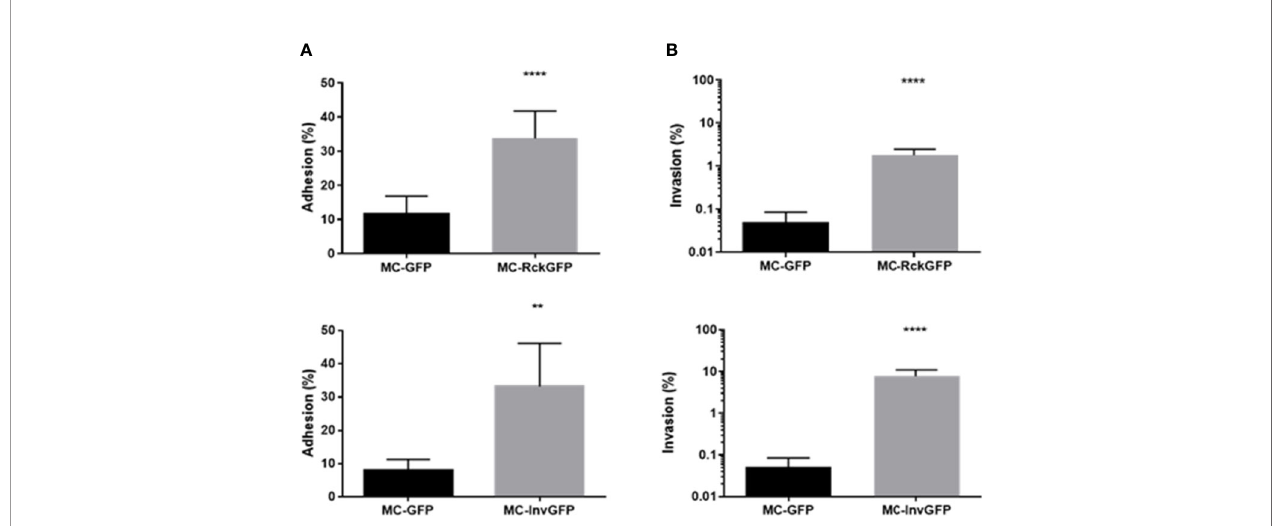
FIGURE 1 | S. Typhimurium Rck and Y. enterocolitica Invasin are able to induce both adhesion and invasion in intestinal epithelial cells. HCT116 cells were infected with MC-GFP, MC-RckGFP or MC-InvGFP strain for 1 h at 37°C (MOI 10:1). The percentage of total cell-associated (A) and intracellular (B) bacteria were calculated as the ratio of CFU of cell lysates and inoculum as described in Materials and Methods . Results are mean ± SD of results obtained from three independent experiments with two infected wells per experiment. Data were compared using a Mann-Whitney test (**p < 0.01; ****p <